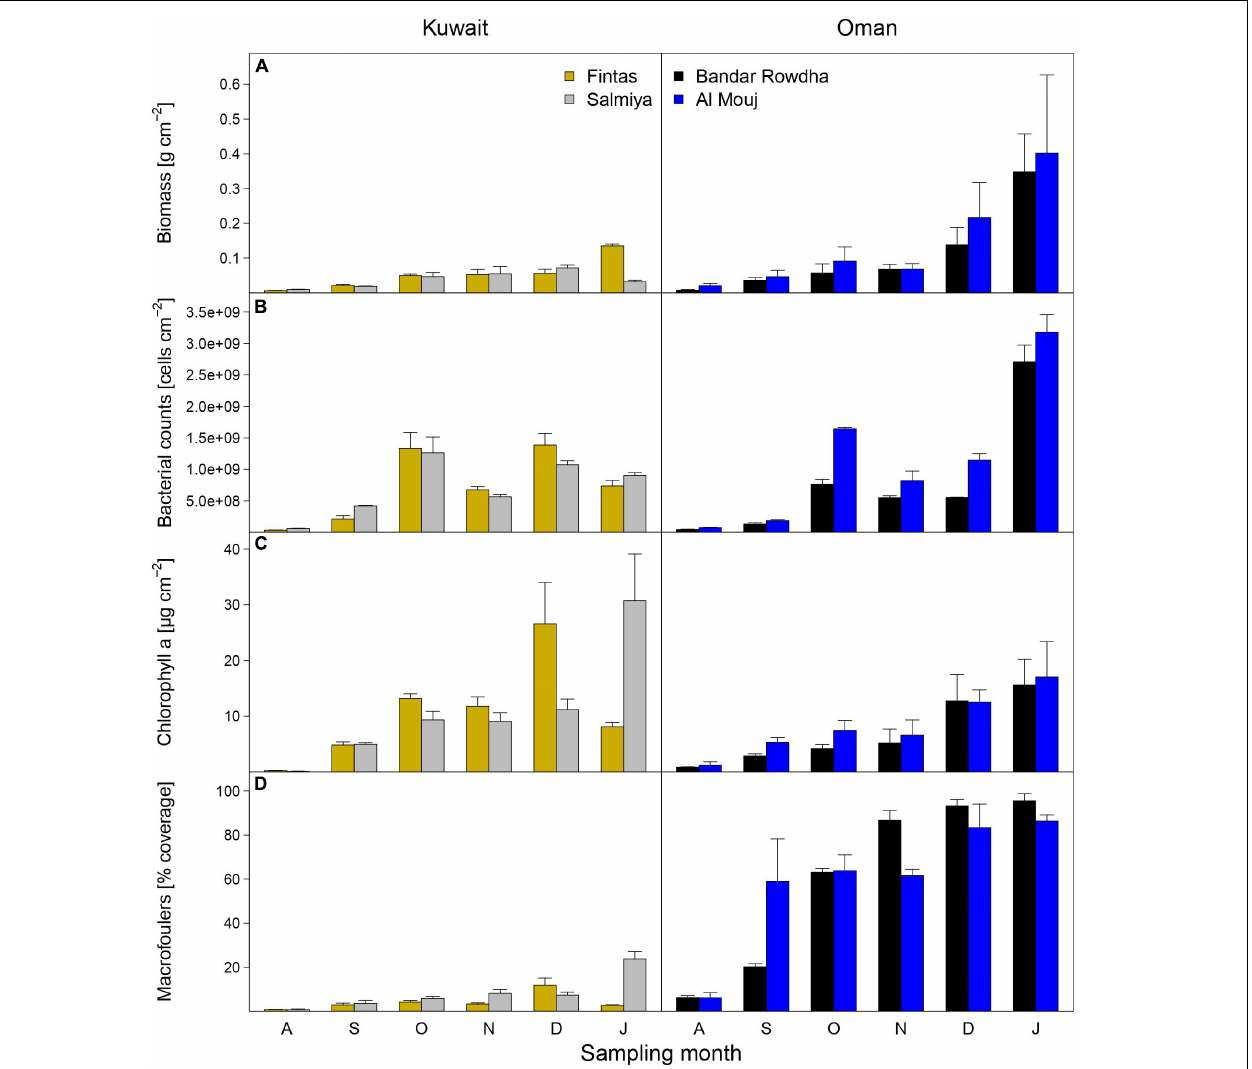
FIGURE 2 | The abundance of biofouling communities as estimated using measurements of (A) total biomass, (B) bacterial counts, (C) chlorophyll a concentration, and (D) macrofouler coverage at the sampling locations in Kuwait (Fintas and Salmiya) and Oman (Bandar Rowdha and Al Mouj) during the sampling period of 6 months from August 2017 to January 2018 (abbreviated as A, S, O, N, D, J). Data presented as mean ± standard deviation ( n =